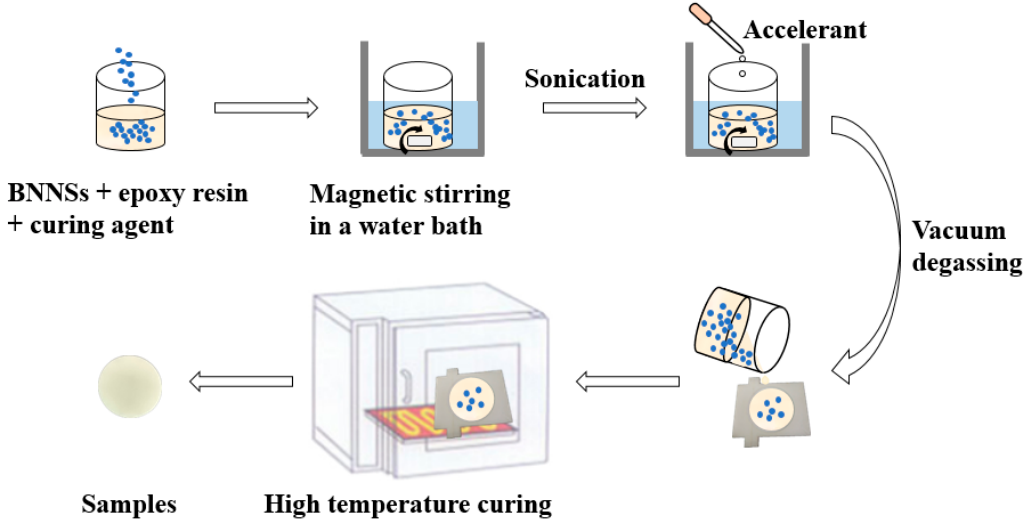
Figure 5. Preparation process of the epoxy composites.